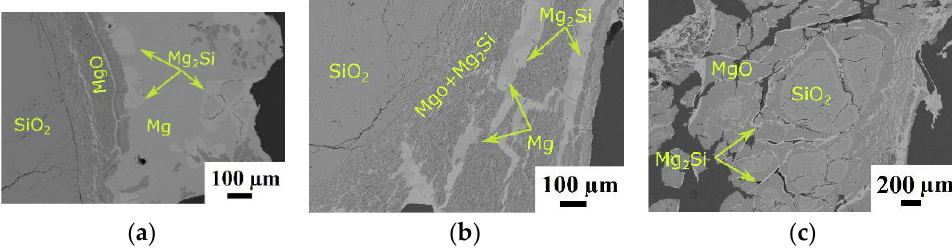
Figure 1. Backscattered electron images of samples at a Mg/SiO 2 mole ratio of 2, 1173 K and different reaction times: ( a ) 10 min; ( b ) 20 min; ( c ) and 120 min.